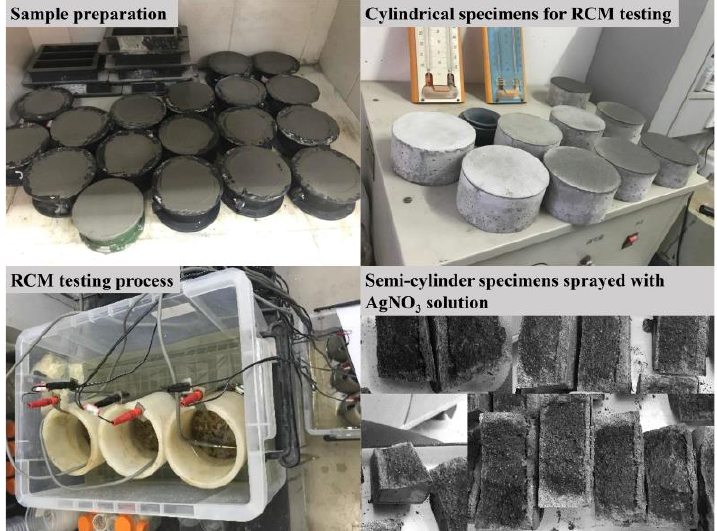
Figure 4. Experimental process of RCM test.